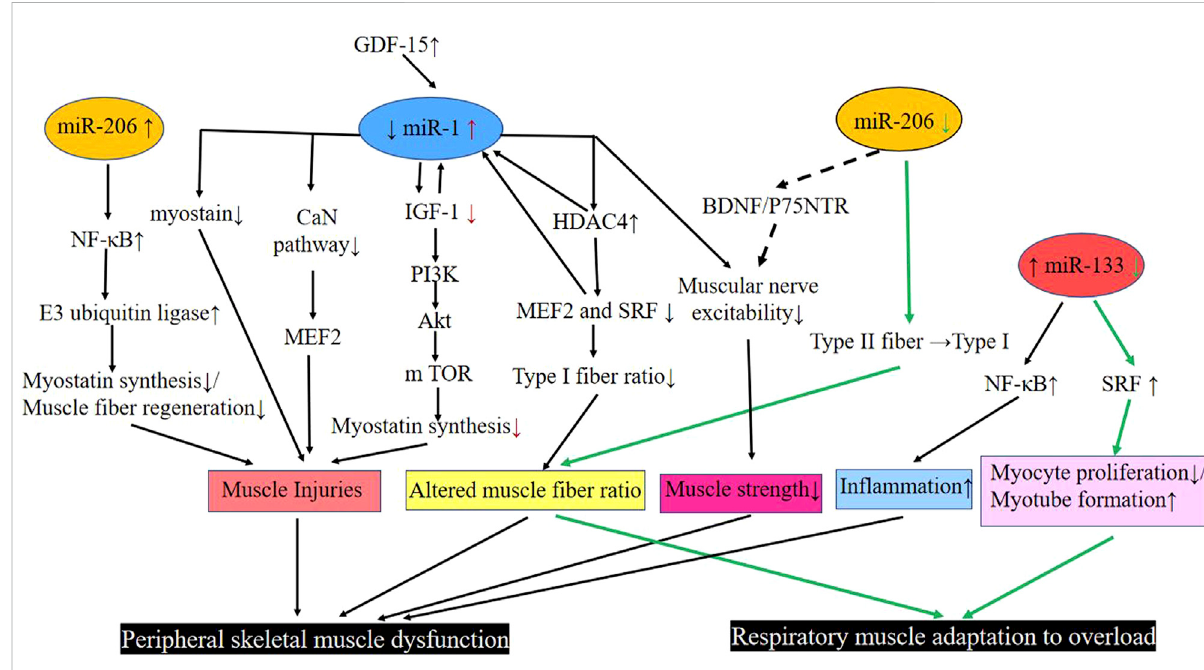
FIGURE 1 Pathways involved in miR-1, − 206, and − 33 regulation of respiratory muscle and peripheral skeletal muscle dysfunction in COPD. Black line: Peripheral skeletal muscle dysfunction; Green line: Respiratory muscle adaptation to overload. Abbreviations: Akt, protein kinase B; BDNF, brain- derivedneurotrophicfactor; CaNpathway,calcium-regulatedneurophosphatasepathway;COPD,chronicobstructivepulmonarydisease;GDF-15, growth differentiation factor 15; HDAC4, histone deacetylase 4; IGF-1, insulin-like growth factor-1; m TOR, mammalian target of rapamycin; Myostatin,musclegrowthinhibitor;MEF2,muscleenhancementfactor2;NF- κ B,enhanced κ -lightchainofnuclearfactor-activatedBcells;P75NTR, neurotrophic factor receptor; PI3K, phosphatidylinositol 3 kinase; SRF, serum response factor; down ( ↓ ); up ( ↑ ); transform ( →